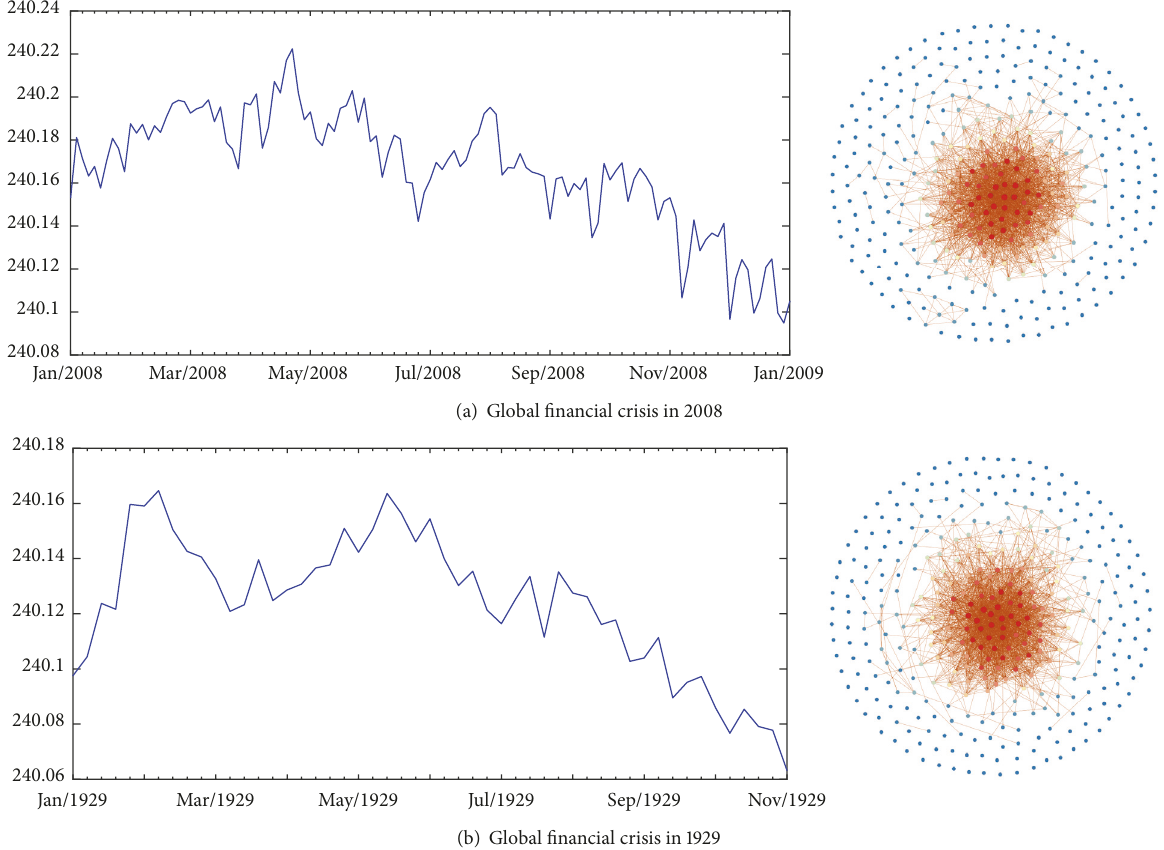
Figure 7: The comparison of network topology at two different global financial crises in 1929 and in 2008.